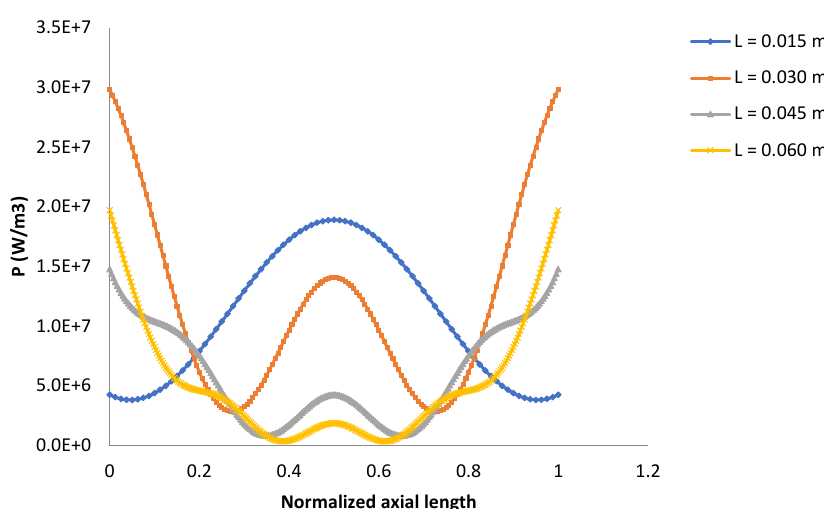
Figure 4. Profiles of heat generation along the center line of cylindrical ilmenite due to microwave heating with respect to the variation of cylinder thickness.